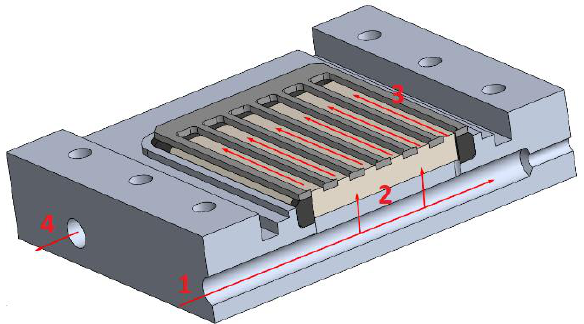
Fig. 4. The schematic diagram of the fluid flow in the